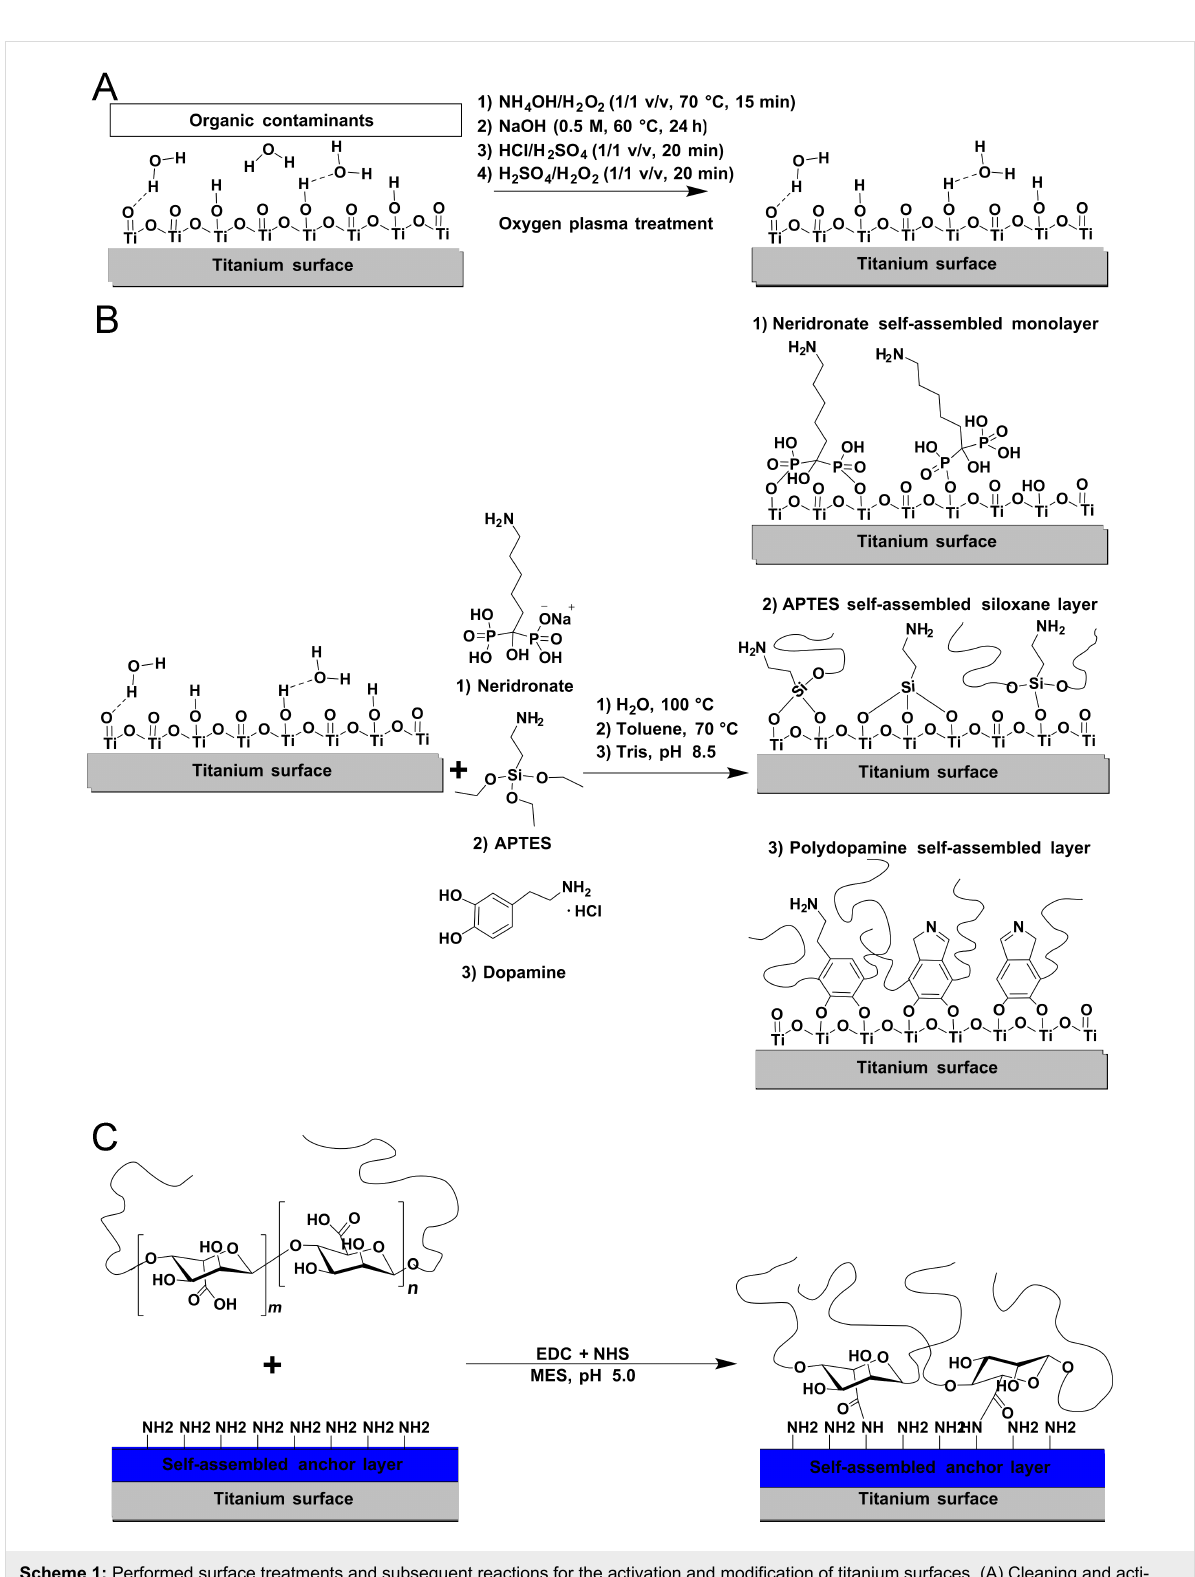
Scheme 1: Performed surface treatments and subsequent reactions for the activation and modification of titanium surfaces. (A) Cleaning and acti- vation procedures for the removal of inorganic and organic contaminants from the titanium surface and to increase the number of free hydroxy groups. (B) Immobilization of neridronate, APTES siloxane and poly(dopamine) anchor layers through surface specific reactions between the phosphonate, silane and catechol groups of corresponding compounds and hydroxy groups on the surface. (C) Covalent binding of ALG chains to amino groups present in the anchor layers by the EDC/NHS coupling